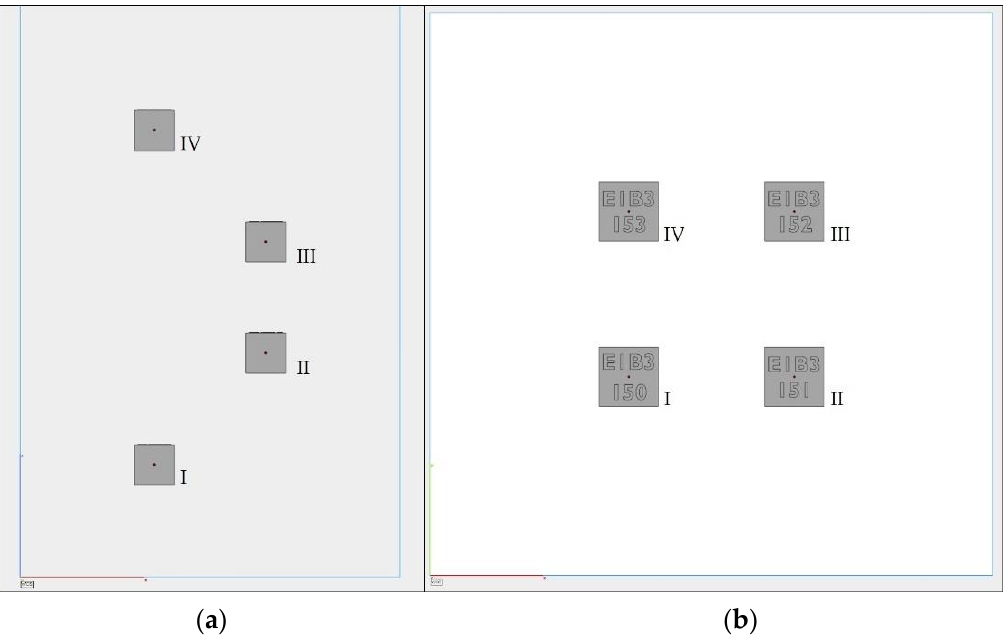
Figure 9. Locations for powder sample boxes. Roman numerals (I–IV) indicate the positions of specimens 150–153. ( a ) Front view; ( b ) top view showing the labeling of the